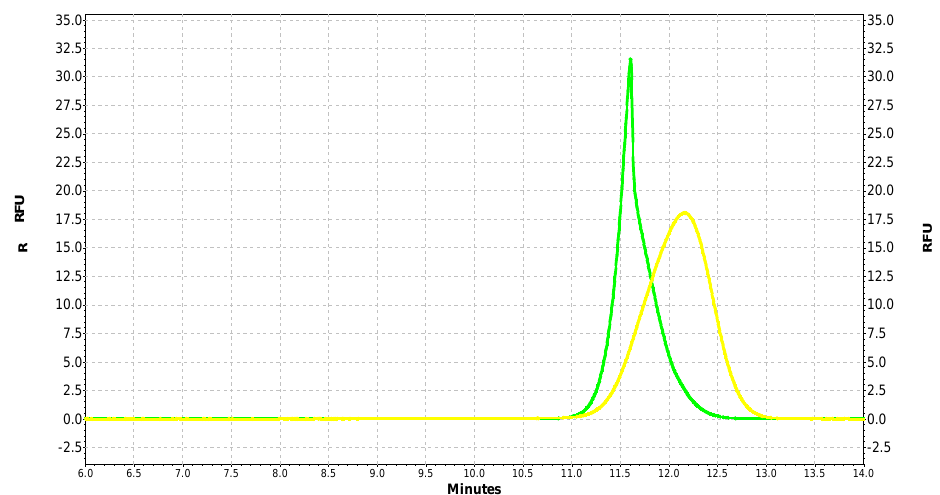
Figure 6. An electrophoretic diagram of G-QD (green) and Y-QD (yellow) separation using CE with an LIF detector. G-QDs with SOD1 separation showed the highest value of fluorescence when the lowest concentration of SOD was applied, and the lowest value of fluorescence for G-QDs alone (Figure 7).